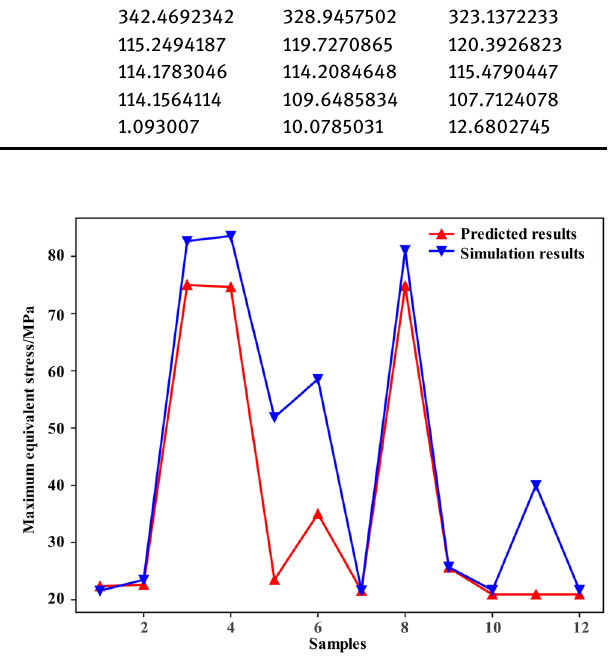
Figure 11: Maximum equivalent stress results of simulation and